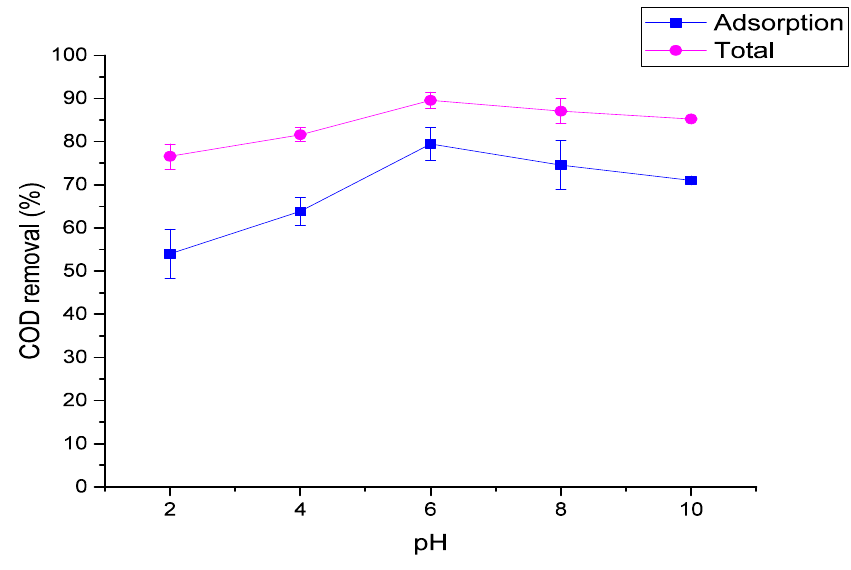
Figure 4. Effect of pH on COD removal.